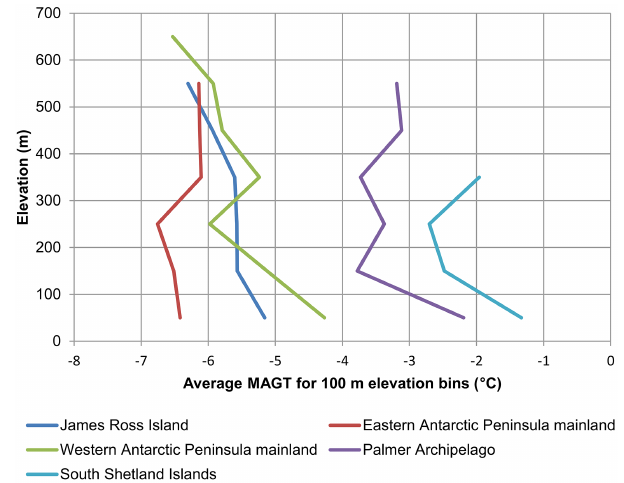
Figure 17. Altitudinal MAGT gradients for the northern Antarctic Peninsula calculated for 100m elevation